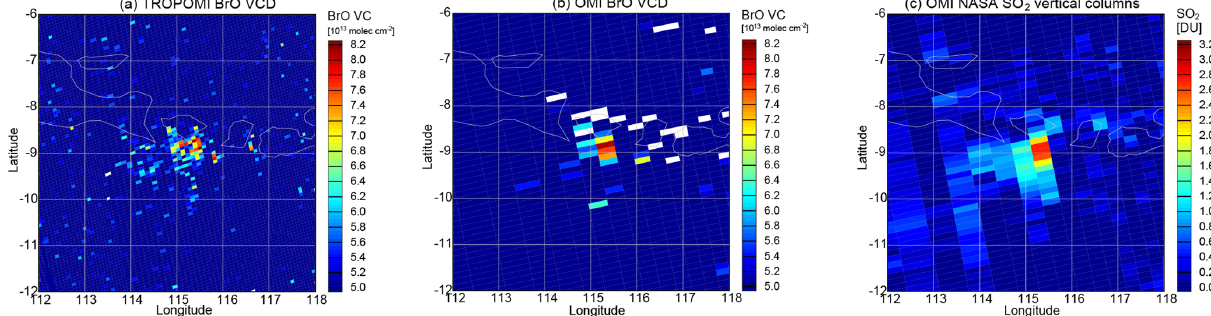
Figure 16. Volcanic BrO vertical columns (10 13 moleculescm − 2 ) on 29 November 2017 after volcanic eruptions at Mount Agung on the Indonesian island of Bali observed by (a) TROPOMI and (b) OMI. (c) Volcanic SO 2 vertical columns (DU) from the column amount SO 2 TRM (mid-troposphere) of the NASA operational OMSO2 product (https://disc.gsfc.nasa.gov/datasets/OMSO2_V003/summary, last access: 23 May